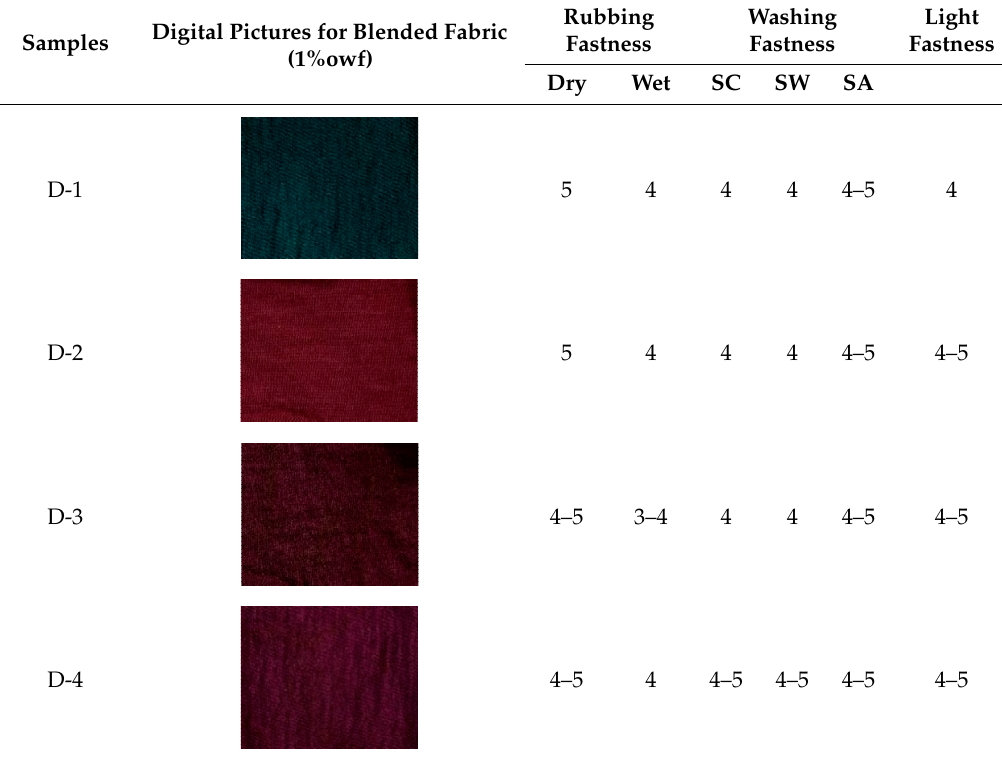
Table 5. Fastness of dyed wool/acrylic blended fabrics at 1.0% (o. w. f) dye concentration a . Samples